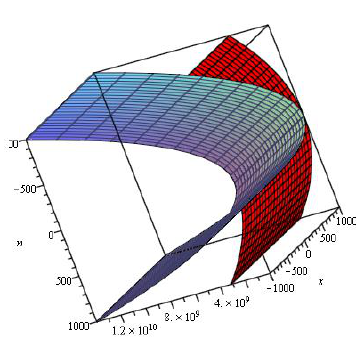
Fig. 5 The red and blue sheets show the comparison result for Revan index of first and second kind Isocahedral network IS n